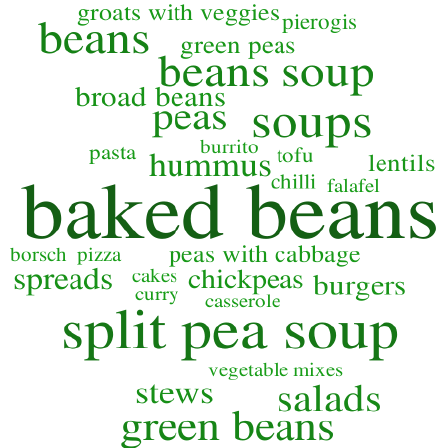
Figure 2. Word cloud based on most popular pulse dishes in the group of urban employees. (Word cloud provided by worditout.com under the Creative Commons License.)